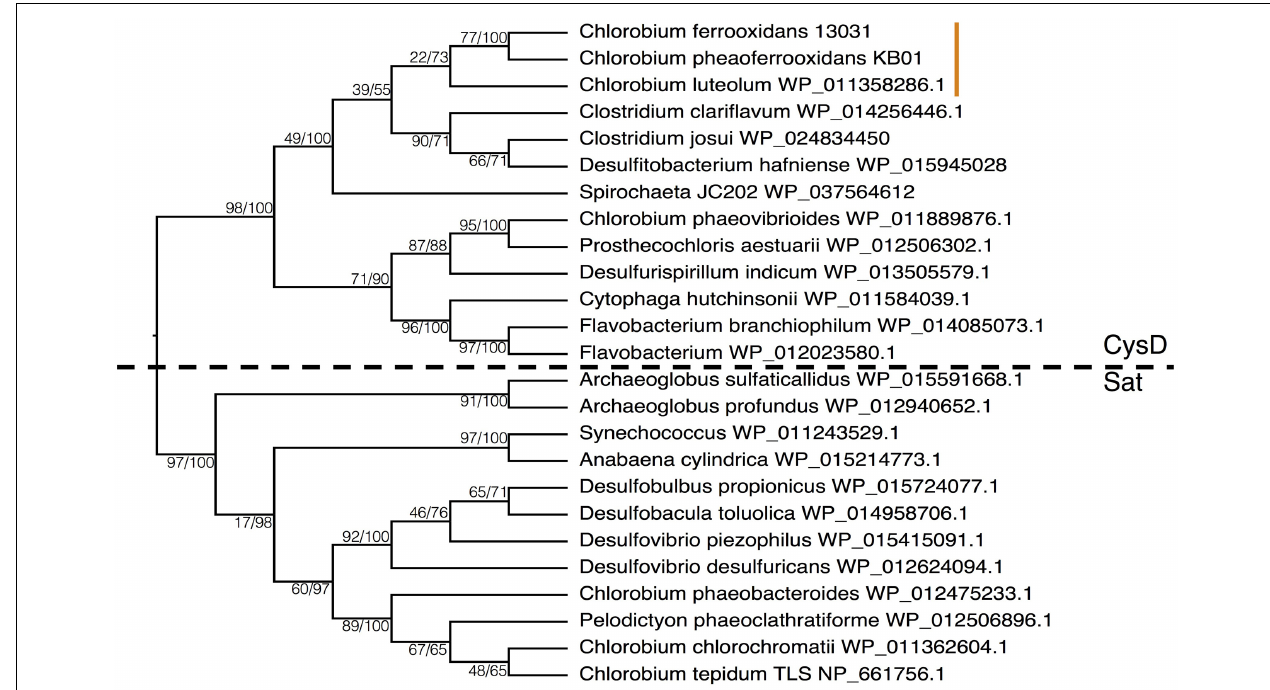
FIGURE 7 | Phylogeny of the Sat/CysD protein with bootstrap values shown at each node (maximum likelihood/maximum parsimony), to compare the ASR and DSR pathway among a diverse set of organisms. The dashed line delineates the organisms with CysD versus those with Sat. The orange line indicates the position of the photoferrotrophic